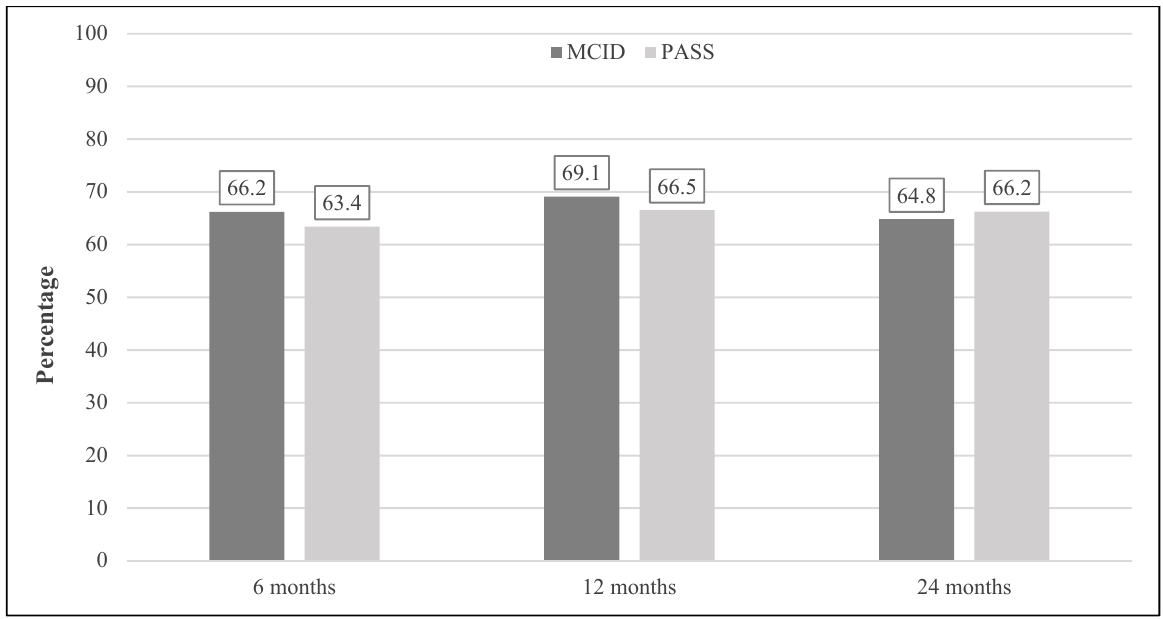
Figure 3. Achievement of the iHOT-33’s MCID and PASS. Postoperative course of hips achieving the iHOT-33’s MCID and PASS. iHOT-33, International Hip Outcome Tool (33 items); MCID, minimal clinically important difference; PASS, patient acceptable symptom state.